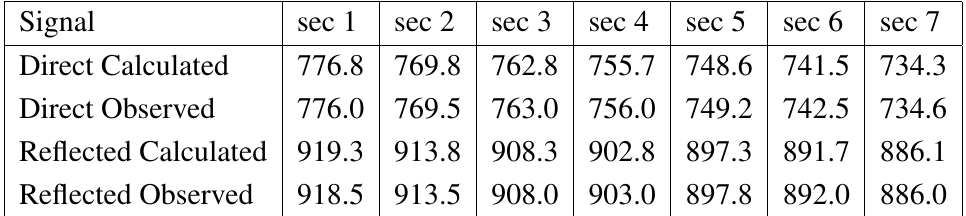
Table 1. Values of the predicted and detected GPS L1 code phases (in chips) for the February 4th 2005 ice